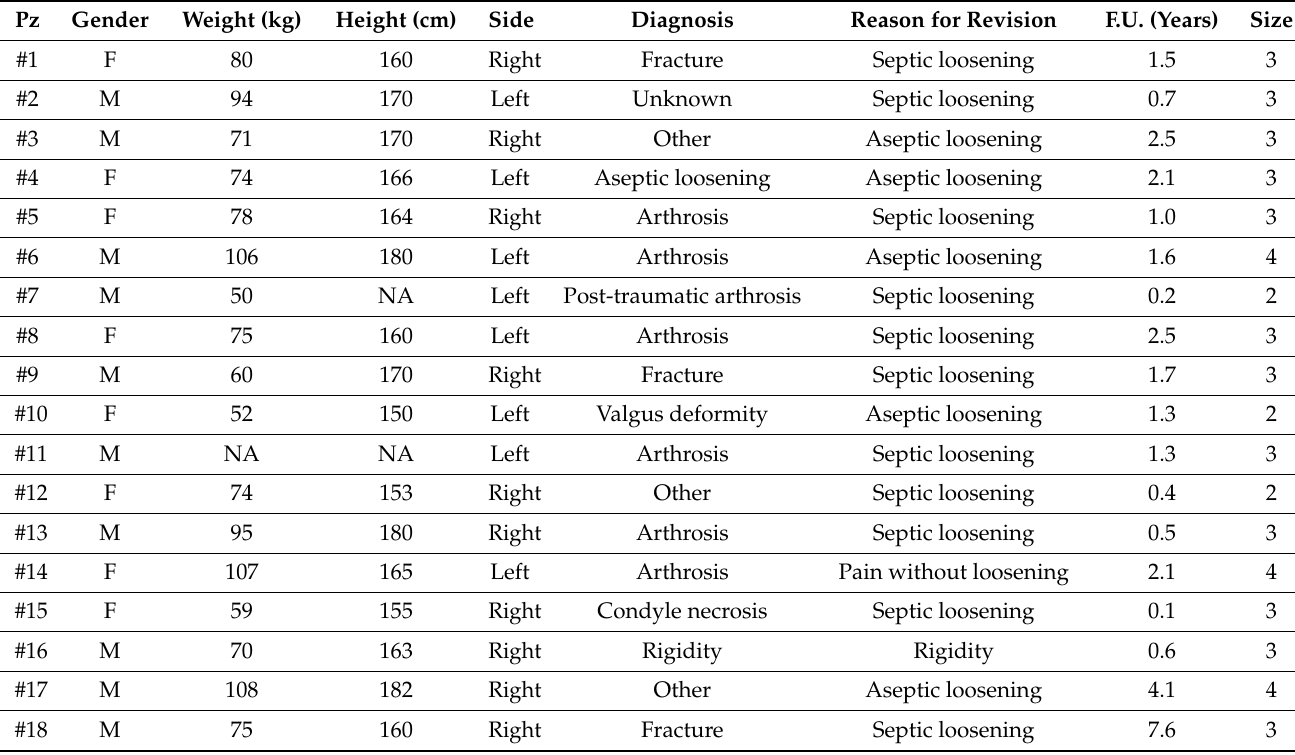
Table 1. Specimen selection, patient characteristics, follow up, and prosthesis